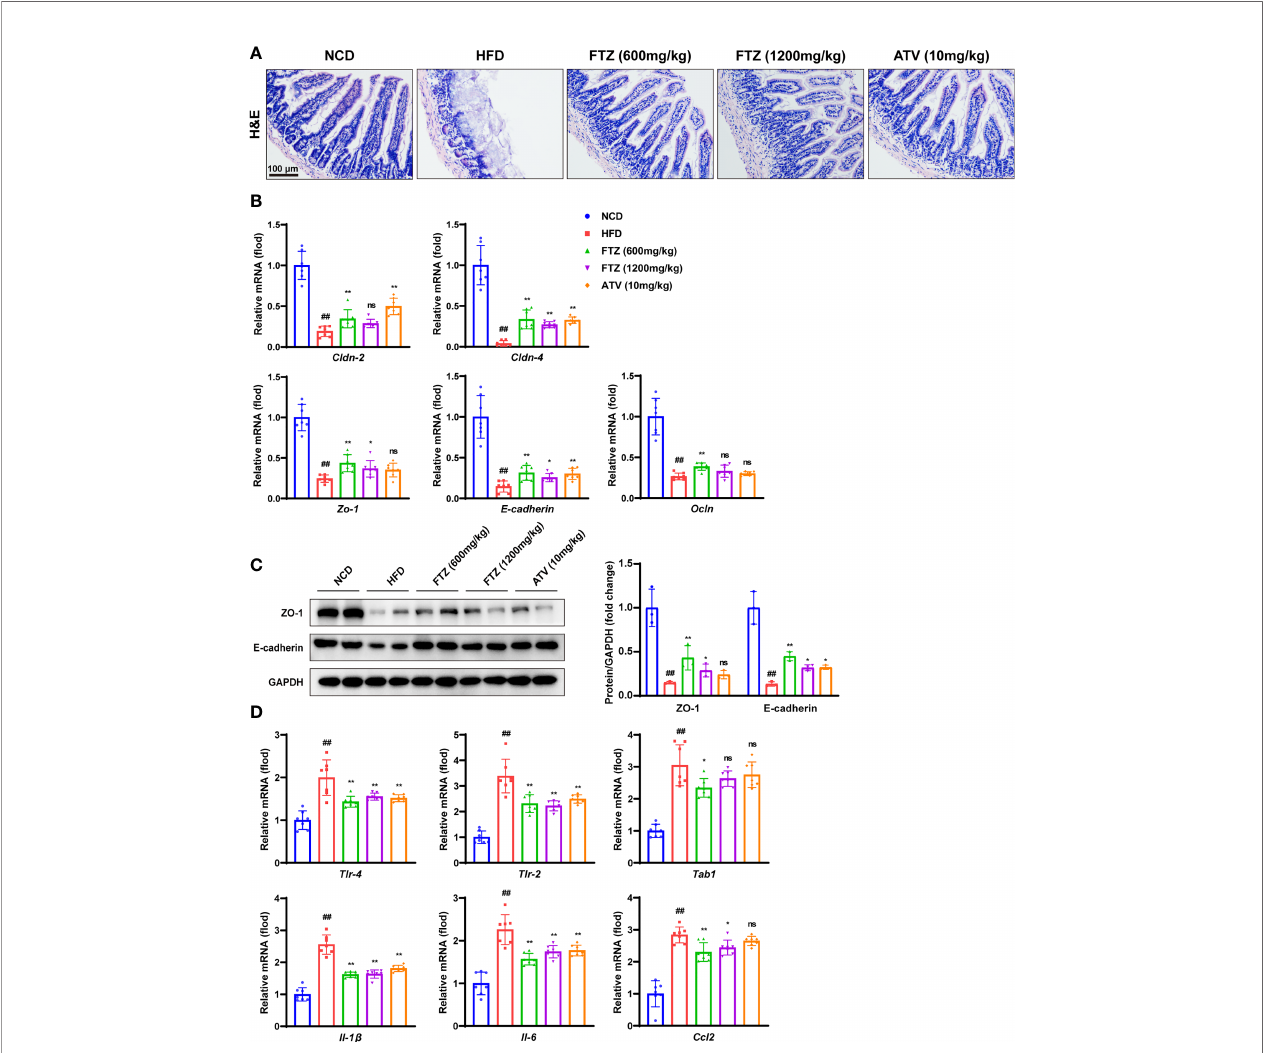
FIGURE 5 | Effects of FTZ on intestinal mucosal barrier and in fl ammation in mice. (A) Representative images of H&E staining of ileum sections. (B) Relative mRNA levels of ileum tight junction molecule genes of the indicated mice (n=7). (C) The expression of ZO-1, E-cadherin, and GAPDH was analyzed by Western blotting. GAPDH served as a loading control (n=3). (D) Relative mRNA levels of ileum in fl ammation genes of mice in the indicated group (n=7). Data are represented as means ± SEM. # indicates a signi fi cant difference between the NCD group and the HFD group (t-test); * indicates a signi fi cant difference between the FTZ (600 mg/kg)/FTZ (1,200 mg/kg)/ATV (10 mg/kg) group and the HFD group (one-way ANOVA). ## P < 0.01 versus NCD mice; * P < 0.05, ** P < 0.01 versus mice fed by HFD. ns indicates no signi fi